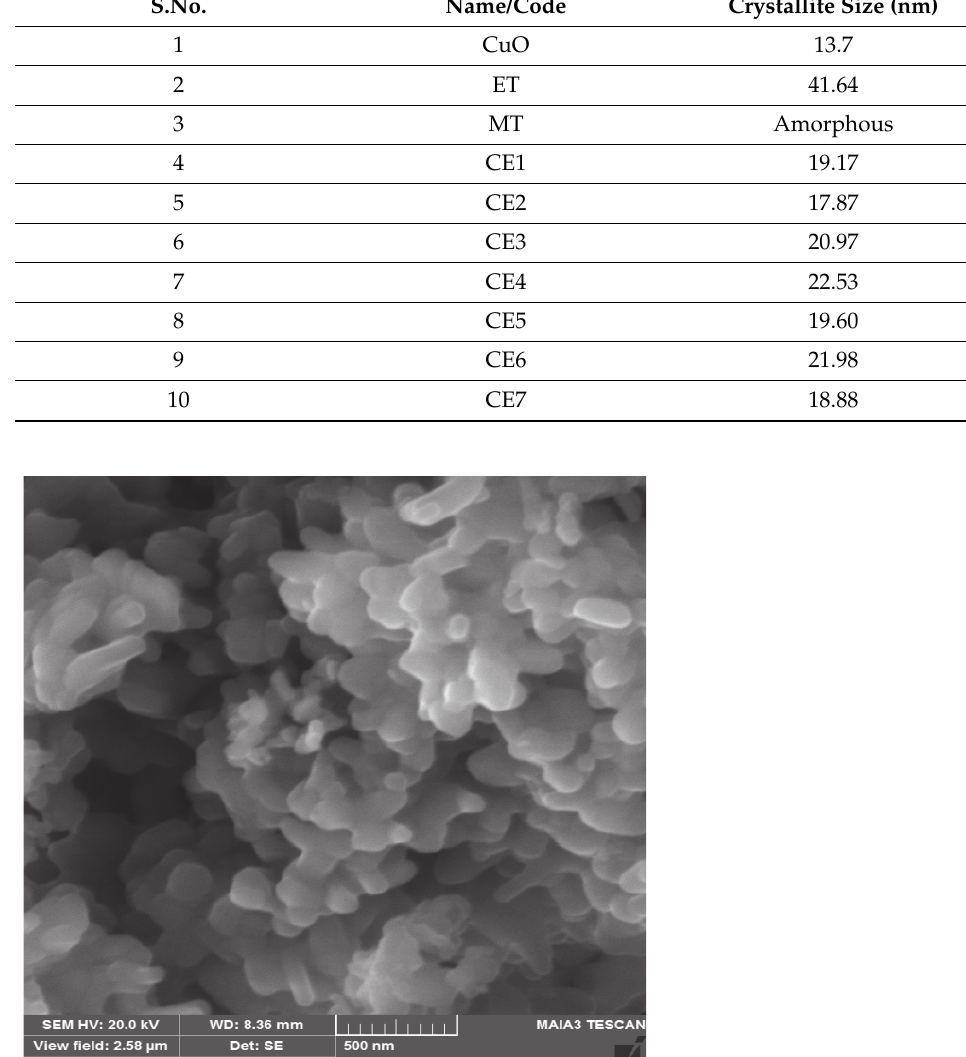
Figure 4. SEM image of CuO NPs.